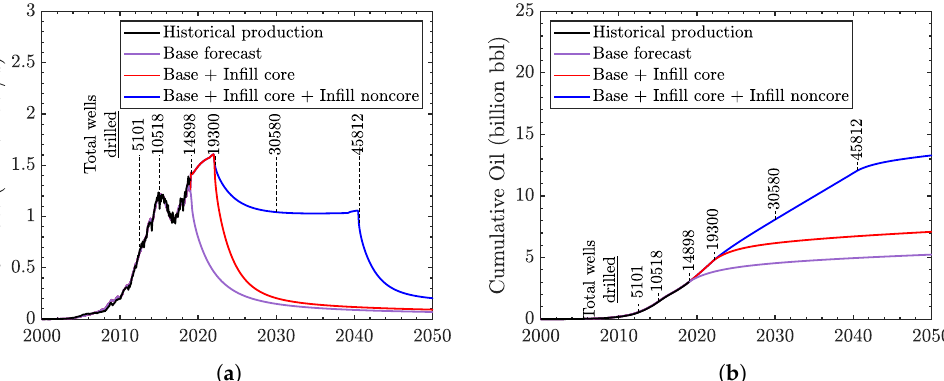
Figure 10. The forecasted total field rate ( a ) and cumulative oil ( b ) for Bakken based on the drilling scenario in Figure 9b. Since we plan to infill the core areas first, the field oil rate will reach the all-time production peak of about 1.6 million bbl/d by mid 2022, leaving no ’sweet spots’ in the core areas. The continuous infill of the less productive wells in the noncore areas will decline the production to a plateau of 1 million bbl/d. After 2041, no more drilling locations will be left in the Bakken region and the oil rate will steeply decline to half a million bbl/d by 2042 and 0.2 million bbl/d by 2050. Ultimately, the 14,898 existing wells will give an EUR of 5 billion bbl. By adding 4402 wells in the core areas, EUR will increase to 7 billion bbl. By adding another 26,512 wells in the noncore areas, EUR will increase to 13 billion